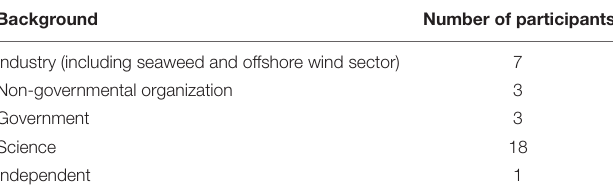
TABLE 2 | Breakdown of workshop